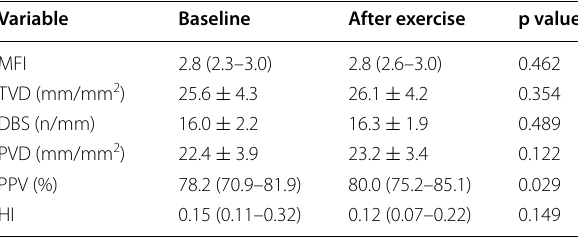
Table 3 Sublingual microcirculation variables at baseline and after